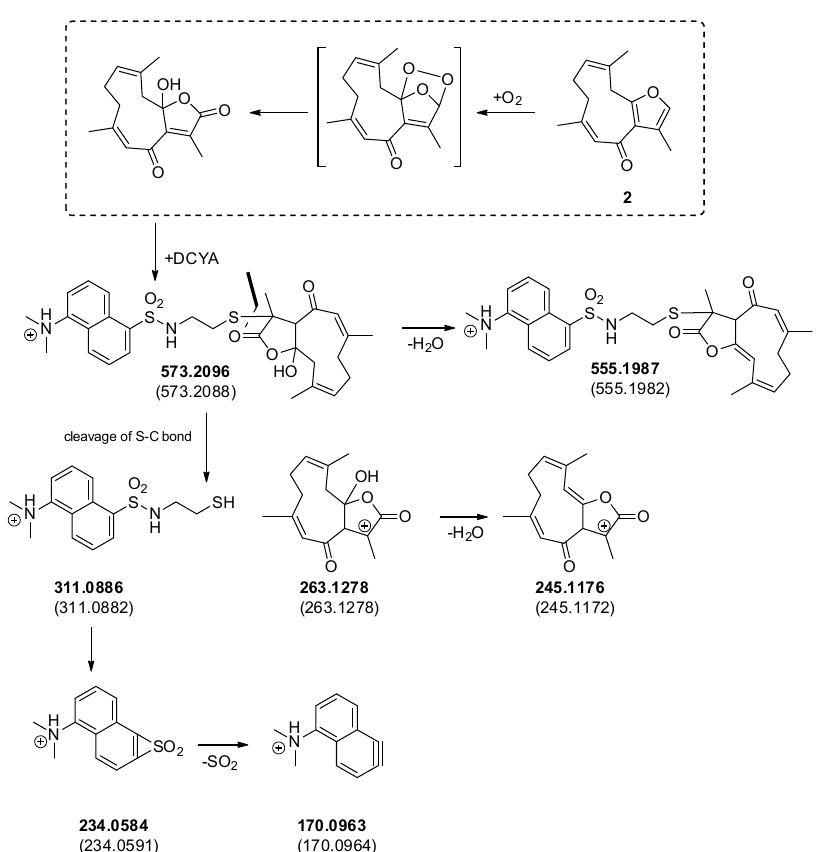
Figure 6. Possible pathways leading to the formation of oxidized DCYA adduct with 2 and the corresponding fragmentation mechanism. Experimental (bold) and calculated mass values (in parentheses) are